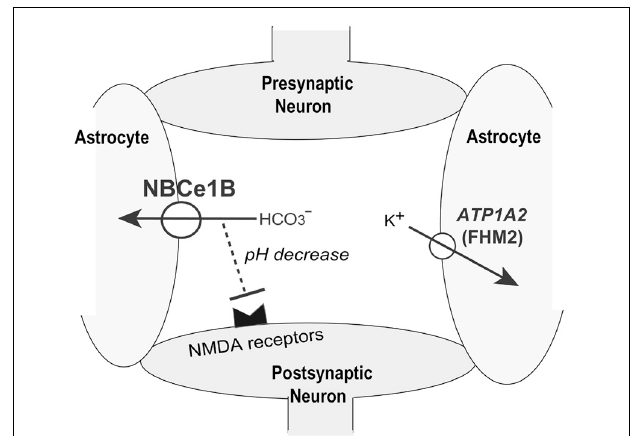
FIGURE 3 | Role of NBCe1B in synaptic pH regulation. K + uptake into astrocytes by ATP1A2 may suppress neuronal excitation. NBCe1-B- mediated local pH decreases may also suppress neuronal excitation by inhibiting pH-sensitive NMDA receptors.